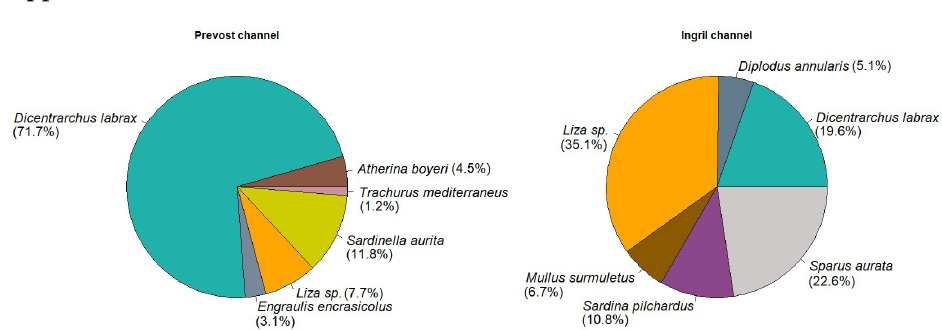
Figure A4. Composition of 15 fish species commercially caught in the two Prévost and Ingril lagoons. Data extracted from [8].